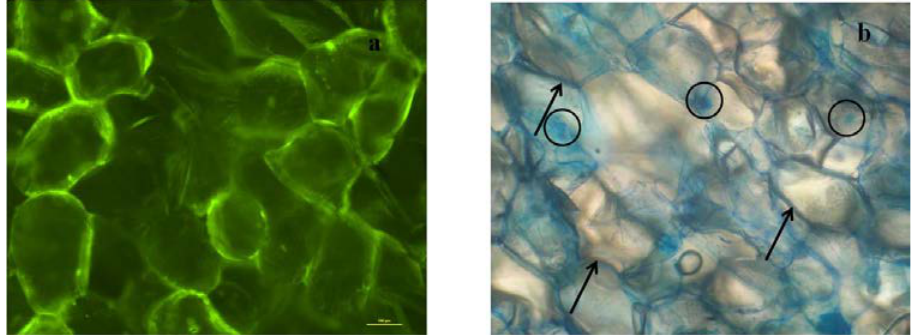
Figure 3. Microphotographs of fresh parenchyma apple tissue stained with ( a ) FDA and ( b ) methylene blue. Arrows point to the cell walls and circles point to the nuclei of the cells.